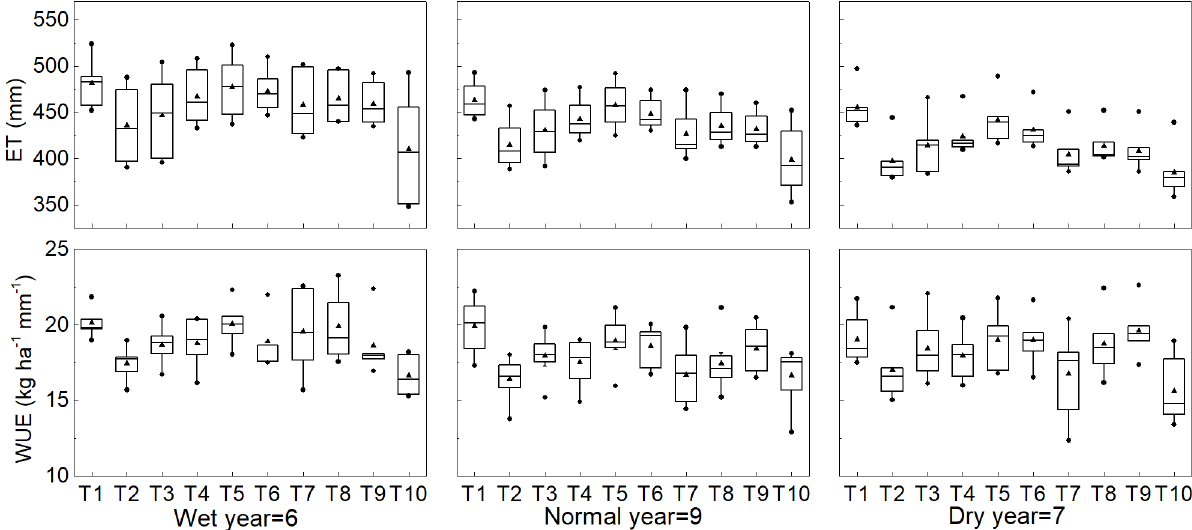
Fig 5. Simulated evapotranspiration (ET) and water use efficiency (WUE) for different treatments. The triangle indicates the median. The circle indicates the 75 and 25 percent. The middle line indicates 50 percent.